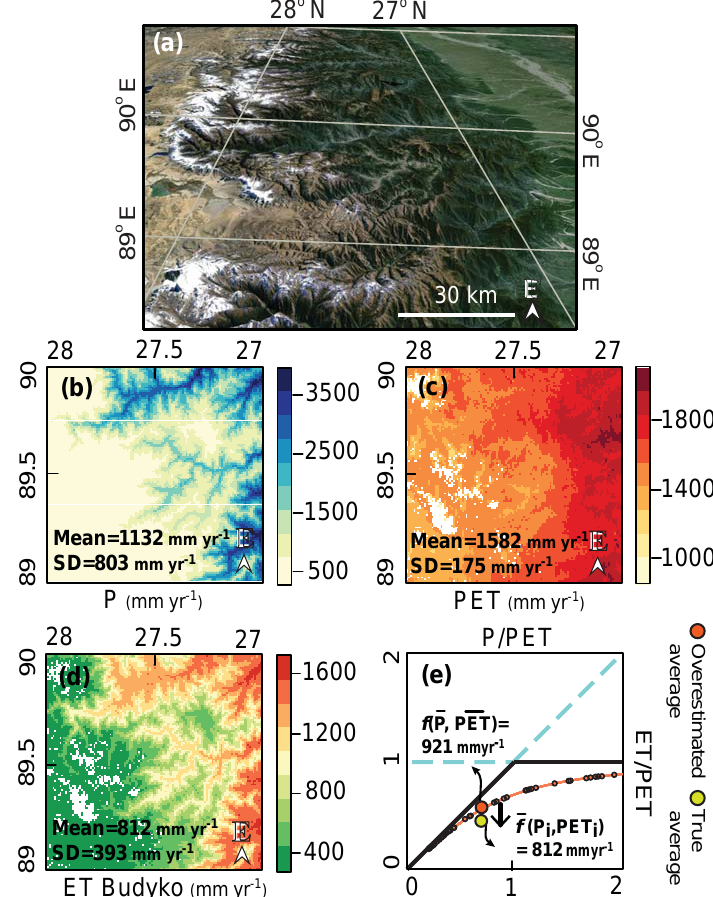
Figure 4. One-kilometer topography ( a : SRTM; Jarvis et al., 2008) and annual mean climatology for a 1 ◦ by 1 ◦ grid cell spanning the Himalayan Front at 89–90 ◦ E, 27–28 ◦ N. Spatial patterns of 1km resolution mean annual precipitation ( b : WorldClim; Hijmans et al., 2005), potential evapotranspiration ( c : MODIS; Mu et al., 2007), and (d) evapotranspiration (ET) calculated using the Budyko curve (Eq. 5). Panel (e) shows a random sample of 50 points from (b) , (c) , and (d) , along with the average P , PET, and ET over the grid cell (yellow circle), and the ET value estimated from Eq. (5) for the same average P and PET (orange circle). This ET estimate is 921mmyr − 1 , 11.8% more than the average of the 1km resolution ET estimates.